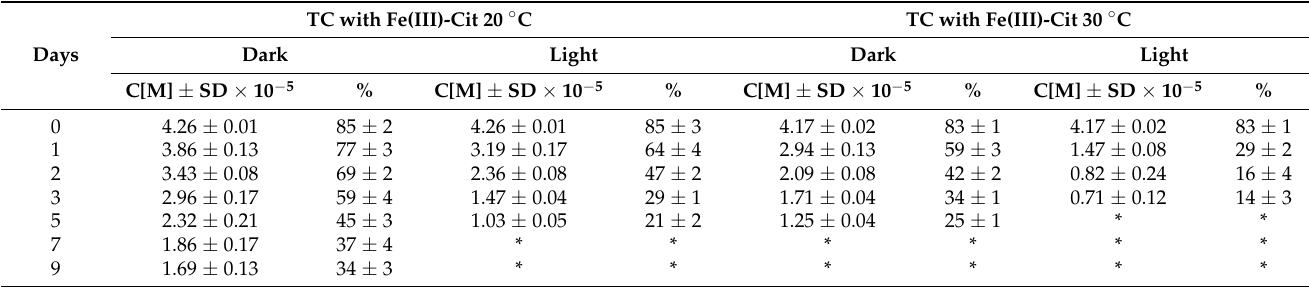
Table 2. Tetracycline (TC) concentration [M] and percent ratio of TC concentration in a solution supplemented with Fe(III)-Cit relative to control for samples stored in darkness or light at 20 ◦ C and 30 ◦